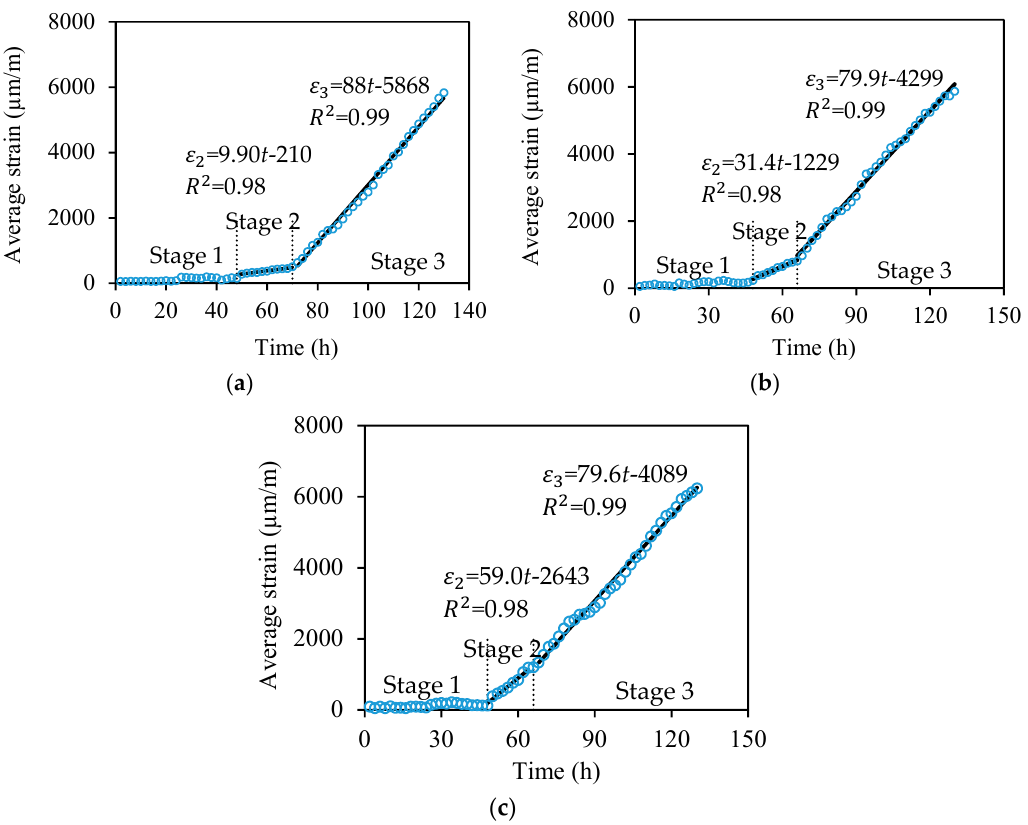
Figure 9. Relationships between the average strain ( ε ) and corrosion test time ( t ) of ( a ) S2, ( b ) S5, and ( c ) S10, show three stages (Stages 1, 2, and 3); in Stages 2 and 3, ε approximately linearly increases with t .